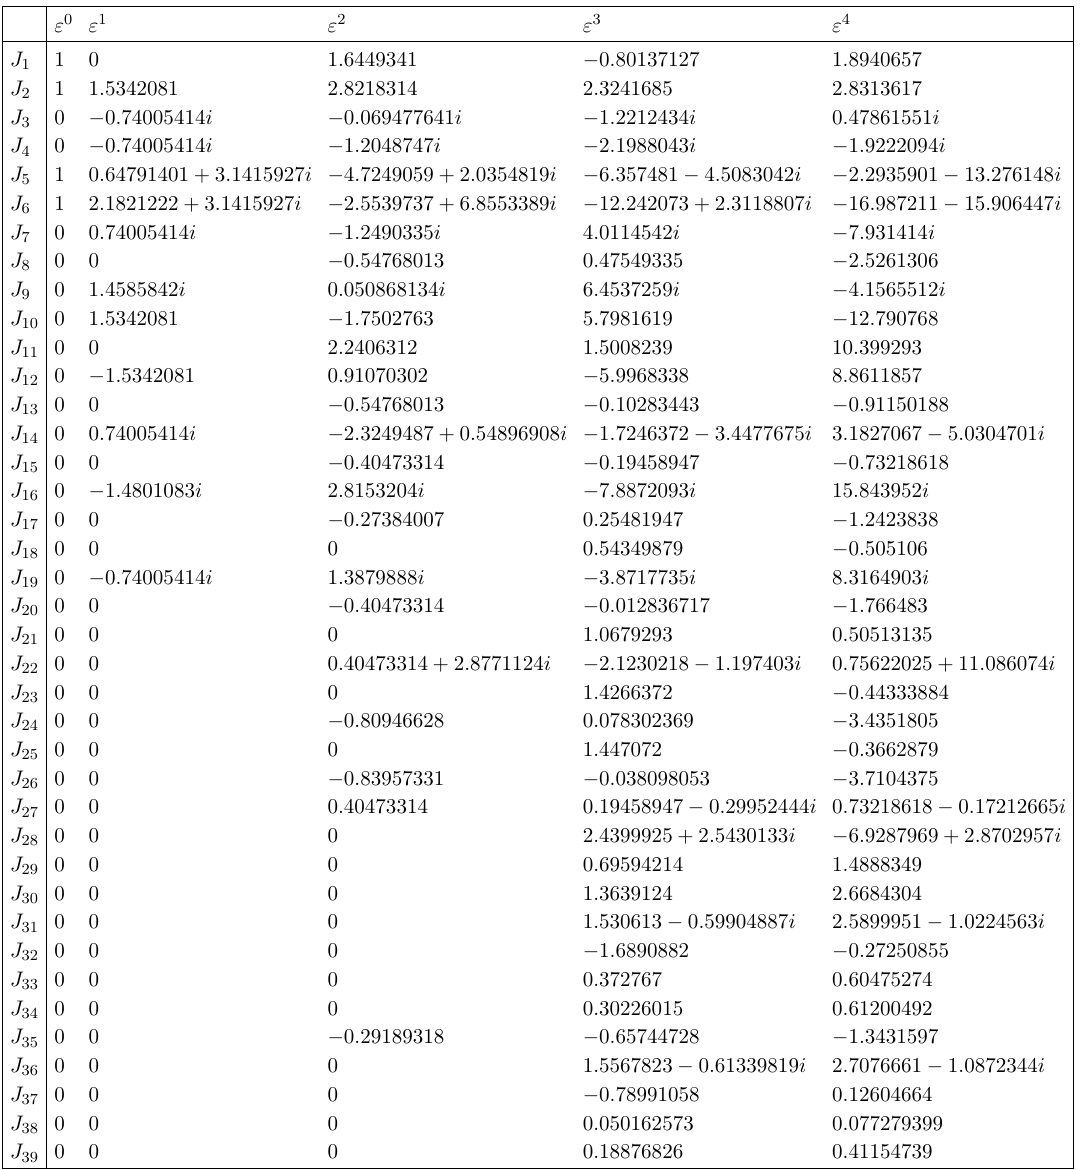
Table 2 . Numerical results for the (cid:12)rst (cid:12)ve terms of the " -expansion of the master integrals J at the kinematic point s = m 2 H